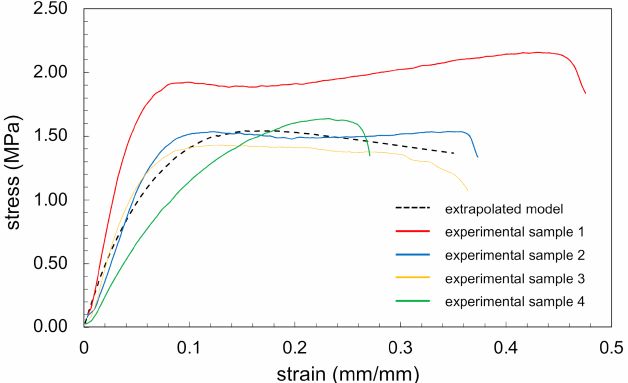
Figure 6. Stress–strain curves obtained in tensile tests of electrospun samples obtained with 4 wt% PEO solution with 20 kV, 20 cm nozzle-collector distance, 0.3 mL/h feed rate, on a rotating mandrel (solid curves), and extrapolated from the FE model (dashed